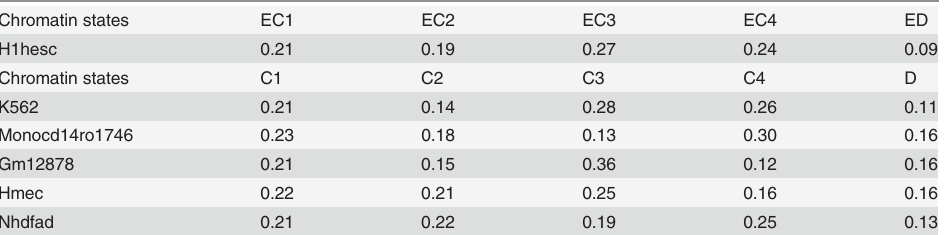
Table 1. Proportions of 28465 sequenced 100-kb windows that belong to the EC1, EC2, EC3 and EC4 chromatin states in H1hesc and to the C1, C2, C3 and C4 chromatin states in differentiated cell